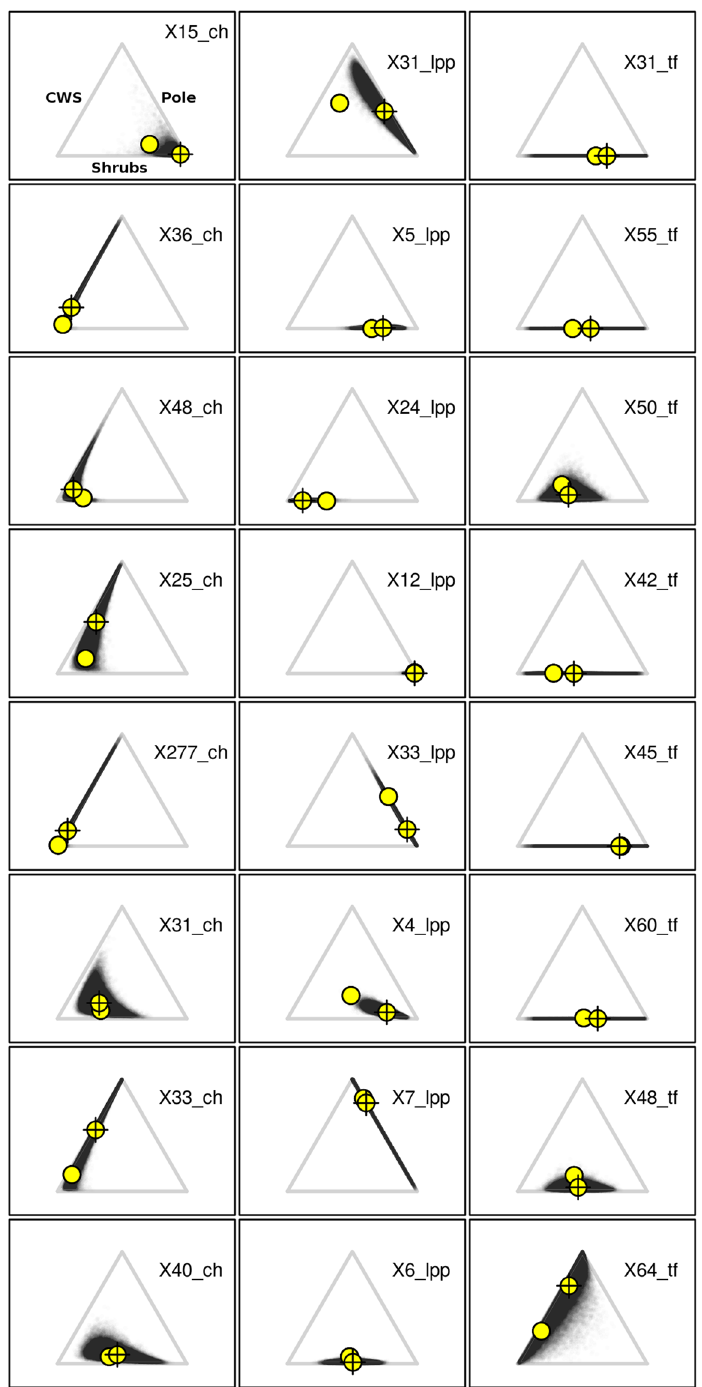
Figure 2. Predicted posterior distribution of the marginality in the ecological triangle for 8 female roe deer selected to be “representative” of the available environmental context experienced in each study area. The left column corresponds to females monitored at Chizé (animal name ending in “_ch”), the central column corresponds to females monitored at La Petite Pierre (animal name ending in “_lpp”), and the right column corresponds to females monitored at Trois-Fontaines (animal name ending in “_tf”). For every possible available home range, we predicted the posterior distribution of the probability of use by calculating, for each vector of parameters sampled by the MCMC, the corresponding predicted vector of proportions of habitat use (each prediction corresponding to a sampled vector of parameter is represented by a translucid grey dot on this plot). For each animal, the distribution of the dots on the ecological triangle represents the distribution of habitat use. The empty circle represents the available habitat within the home range, and the circle with a cross represents the mean of the distribution of habitat use (i.e., mean